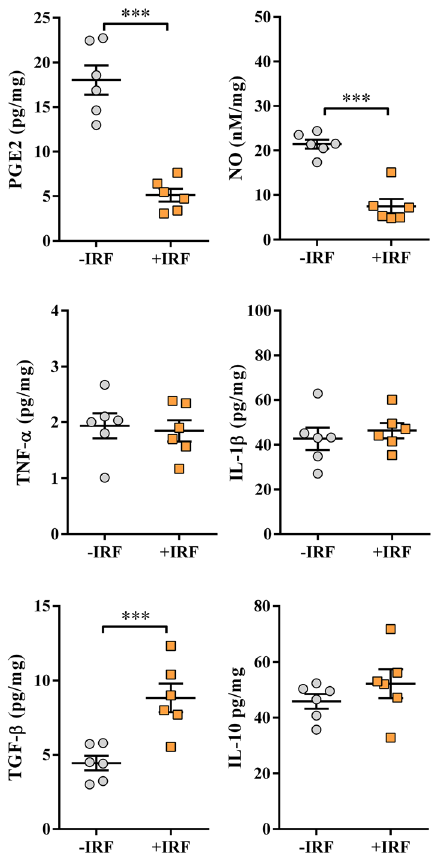
Figure 11. Influence of rat exposure to IR fibre bedding in a treatment paradigm on the production of PGE2, NO, and cytokines by carrageenan-inflamed paws. Scatter plots (created using GraphPad Prism version 7.00 for Windows, GraphPad Software, La Jolla, California, USA; https ://www.graph pad.com) show PGE2, NO, TNF-α, IL-1β, TGF-β and IL-10 production levels in the supernatants from 4 h (PGE2) or overnight carrageenan- inflamed paw tissue cultures (normalized to the paw weight) (see Material and Methods) from rats transferred in cages with IR fibre bedding (+IRF rats) or in cages with standard wooden shaving bedding (−IRF rats) immediately following administration of carrageenan. Results are expressed as mean ± SEM. n = 6 rats/group. *** p ≤